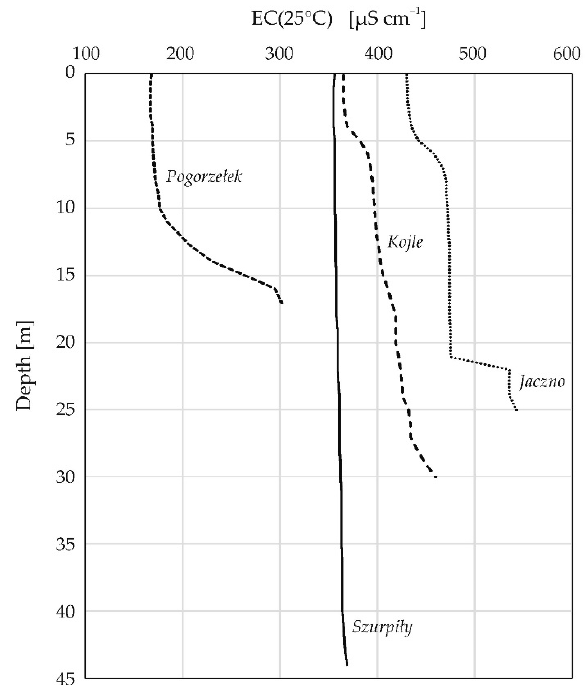
Figure 3. Vertical conductivity temperature profiles at the end of spring mixing period in some SLP lakes in April 2012. Out of all the presented lakes, only the deepest one (Lake Szurpiły) was completely mixed that spring.